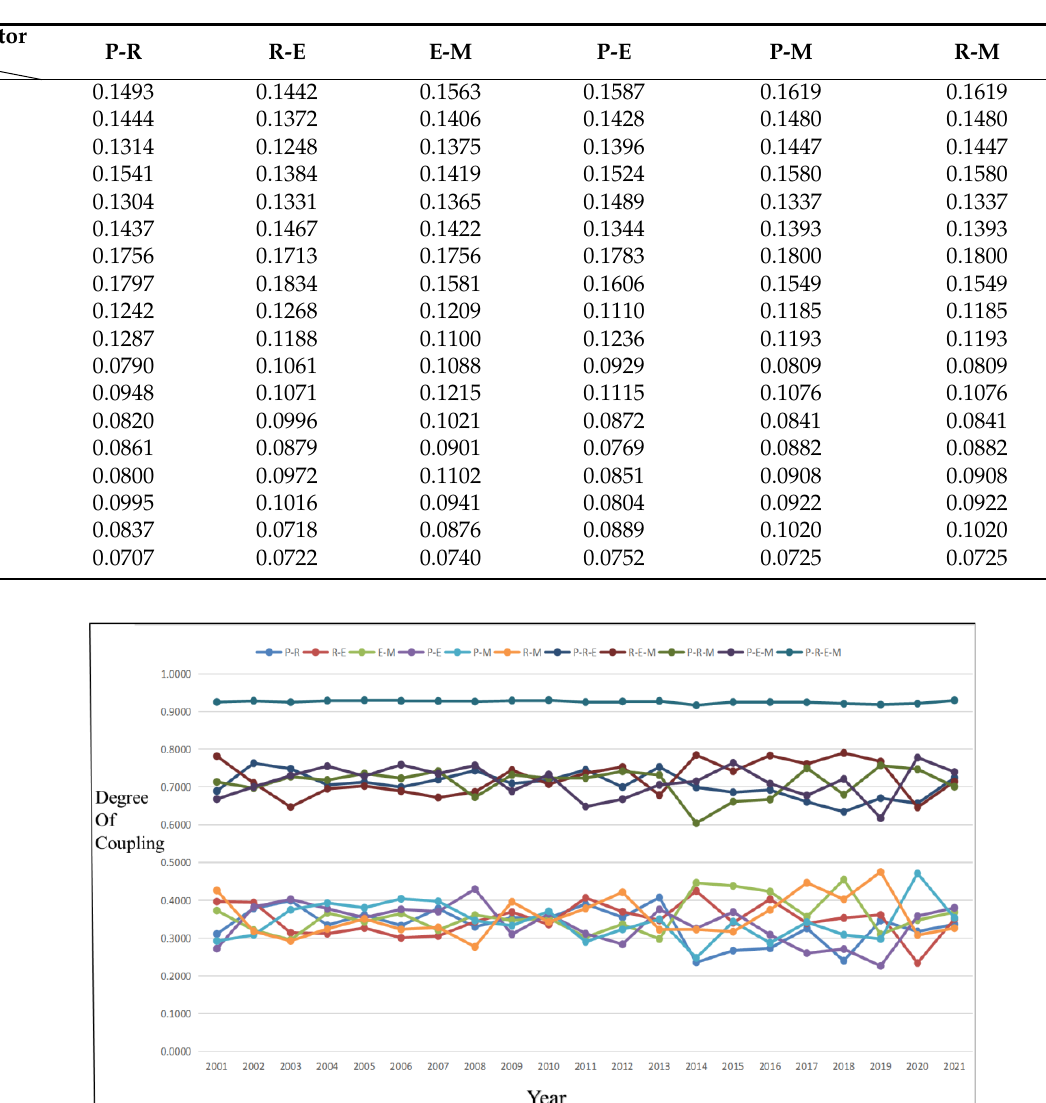
Figure 6. Visualization of comprehensive coordination index calculation results.